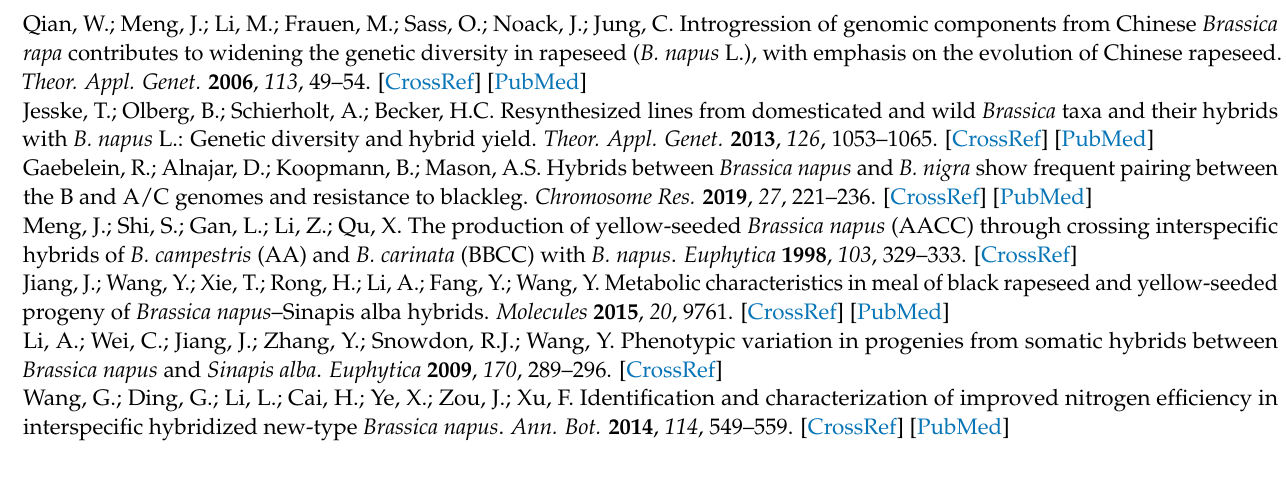
cross F 1 and induced F 1 ; Table S3: Flow cytometry identification results; Table S4: Induced F 1 SNP site